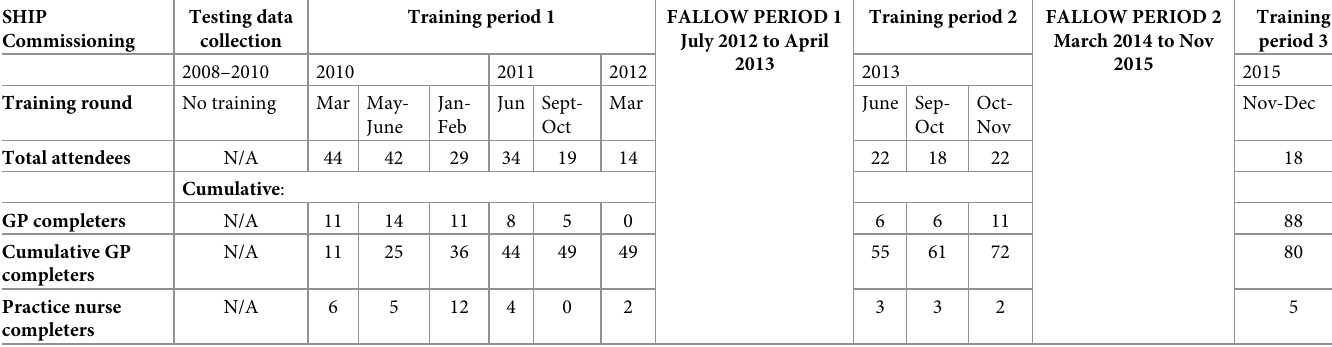
Table 1. GP and practice nurse attendance at SHIP training March 2010 to end